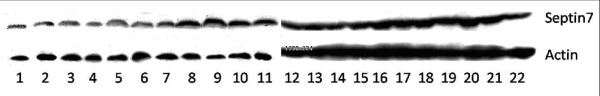
Western blots for selected 21 miRs and Septin7. The Septin7 expression levels were measured (left to right) for (1) control sample, (2) miR-127, (3) miR-182, (4) miR-412, (5) miR-19a, (6) miR-453, (7) miR-448, (8) miR-450, (9) miR-183, (10) miR-141, (11) miR-202, (12) miR-148, (13) miR-106b, (14) miR-134, (15) miR-106, (16) miR-144, (17) miR-151, (18) miR-384, (19) miR-101, (20) miR-142, (21) miR-129 and (22) miR-126. The position 1 is the control sample; positions 2 to 11 inclusive concern 10 miRs for which predictions were obtained either by both PicTar and HiMiTar (positions 2, 3, 5, 9, and 10) or only by HuMiTar while these MiR were not included in the PicTar's database (positions 4, 6, 7, 8, and 11); positions 12 to 22 concern 11 miRs which were predicted by HuMiTar and which were included in the PicTar's database. We note that our analysis lacks results on the mutant targets that would strengthen the claim that the activation results of up-regulation of the predicted miRs. Due to limited resources and since the goal of this work is to present a new in-silico prediction method rather than to investigate whether miRs can up-regulate translation, we note that our conclusions concerning the up-regulation should not be considered as the primary outcome of this work.